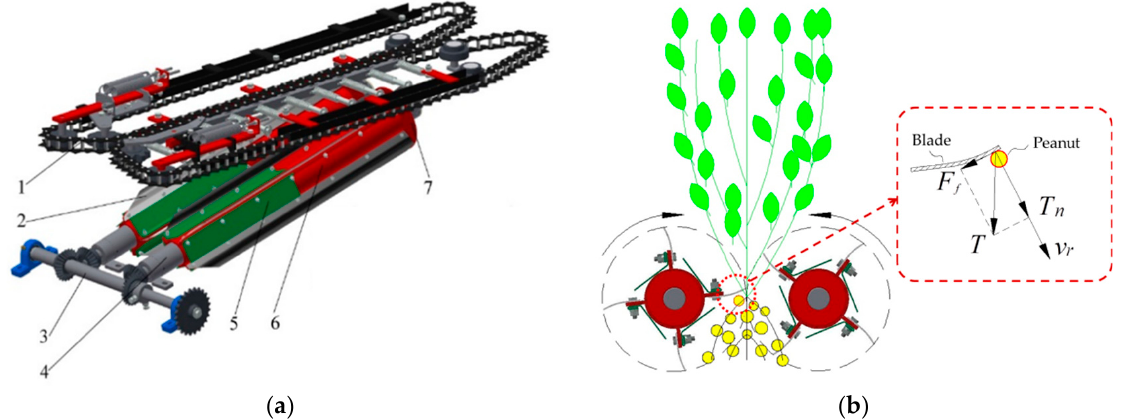
Figure 5. Structural diagram of the peanut-picking device and the force involved in its operation. ( a ) Structural diagram of the peanut-picking device: 1. clamping conveyor chain; 2. blade; 3. drive system; 4. roller shaft; 5. soft film; 6. picking roller; 7. anti-tangle device. ( b ) Force analysis of the interaction between the peanuts and the peanut-picking blades.